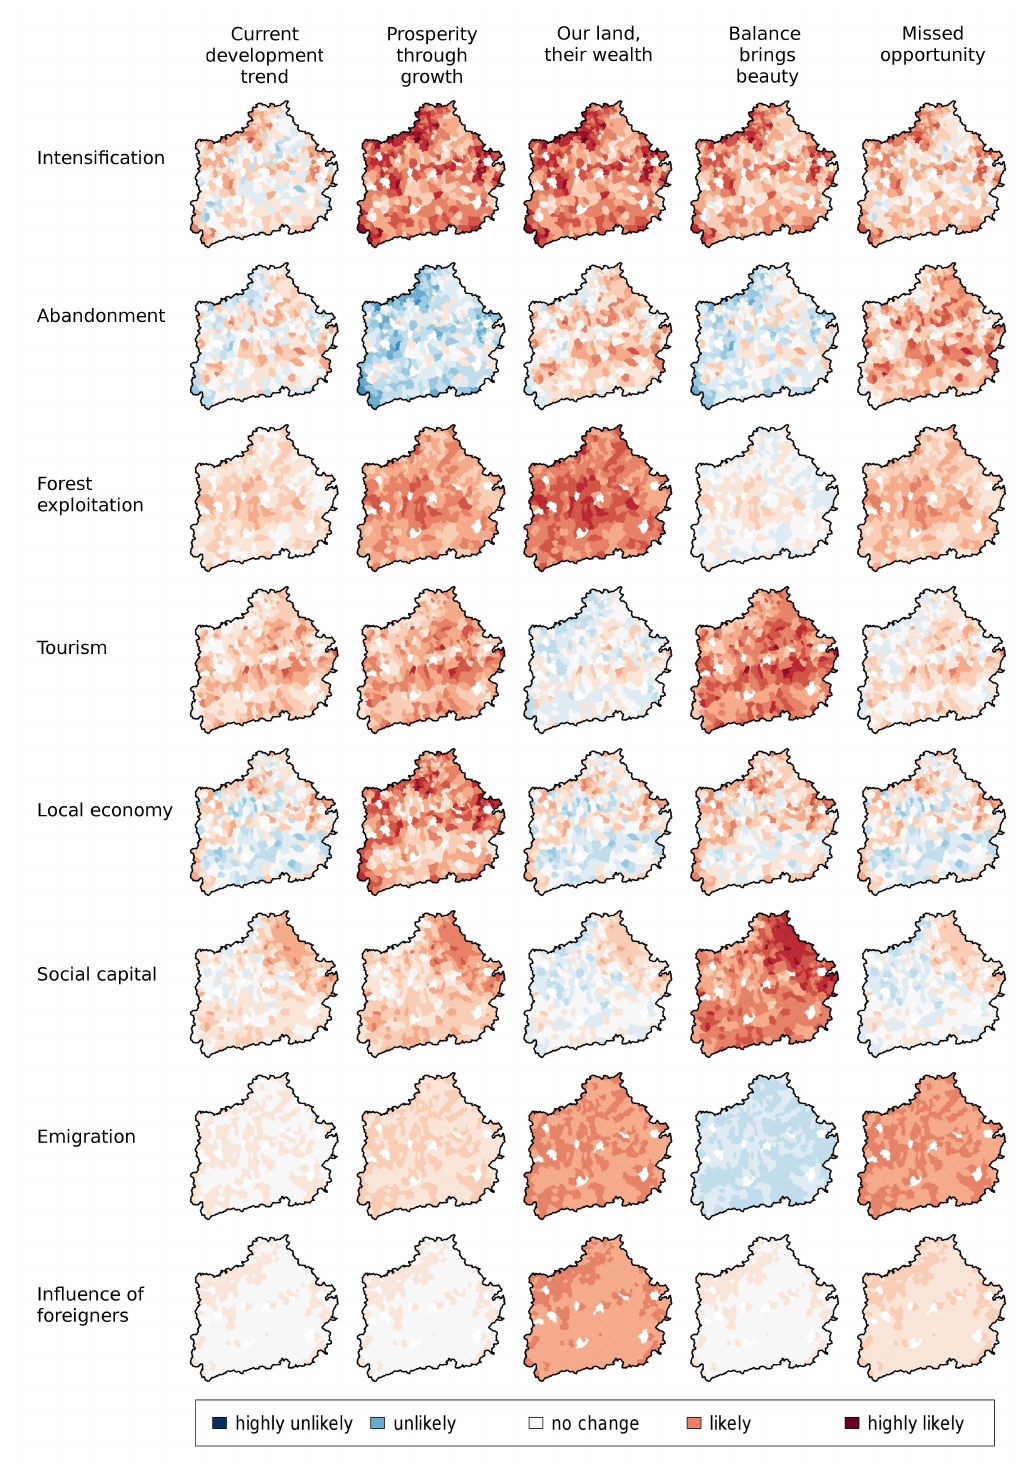
Fig. 8. Maps of current social-ecological development trends (left column) and social-ecological risks and opportunities under the four scenarios (other